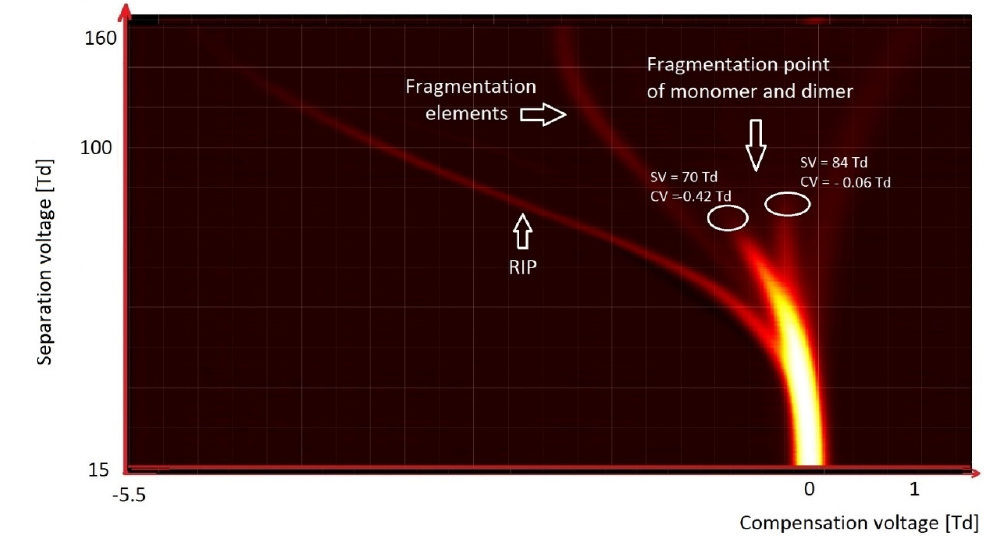
Figure 10. DMS spectrogram of acetone.